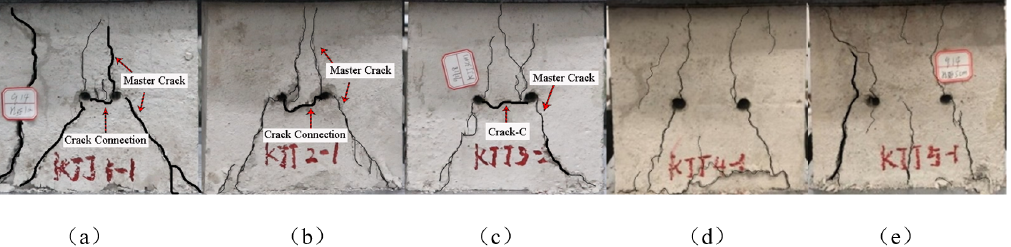
Figure 12. ( a ) is the failure diagram of the sample with 1 cm drilling spacing, ( b ) is the failure diagram of the sample with 2 cm drilling spacing, ( c ) is the failure diagram of the sample with 3 cm drilling spacing, ( d ) is the failure diagram of the sample with 4 cm drilling spacing, and ( e ) is the failure diagram of the sample with 5 cm drilling spacing.